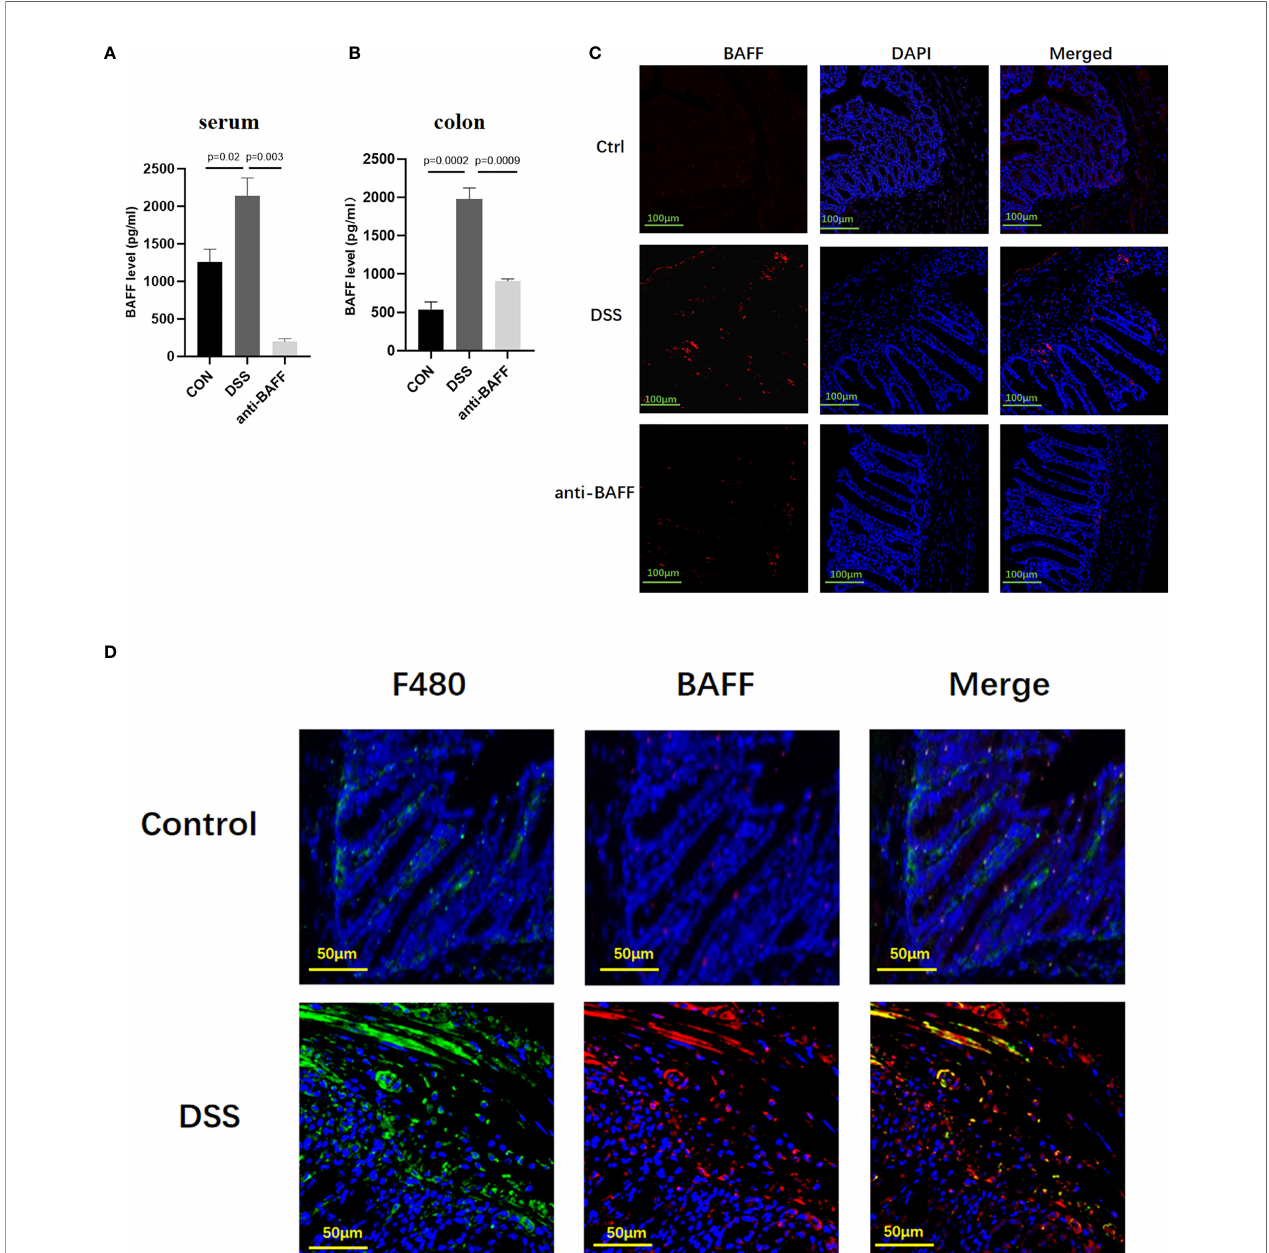
FIGURE 1 | Systemic and local BAFF expression in DSS-induced colitis mice and distribution in intestinal mucosa. To induce chronic colitis, mice were challenged with 2.5% DSS; 5 days of 2.5% DSS, 2 days of sterile water, four cycles. Mice were injected intraperitoneally with BAFF monoclonal antibody (2 mg/kg) on days 1 and 15, while mice in the model group were injected intraperitoneally with IgG1 negative isotype control antibody (2 mg/kg) on days 1 and 15 throughout the modeling period. Blood samples and colon were collected at the indicated time points. (A, B) Samples were assayed for BAFF concentrations by ELISA. (C) Immuno fl uorescence of BAFF and DAPI staining in the colon tissues (n = 6 – 9 per group). (D) Dual-colored immuno fl uorescence staining was used to determine the expression of F4/80 (speci fi c for monocytes/macrophages) (green fl uorescence) and the expression of BAFF (red fl uorescence). Ctrl,